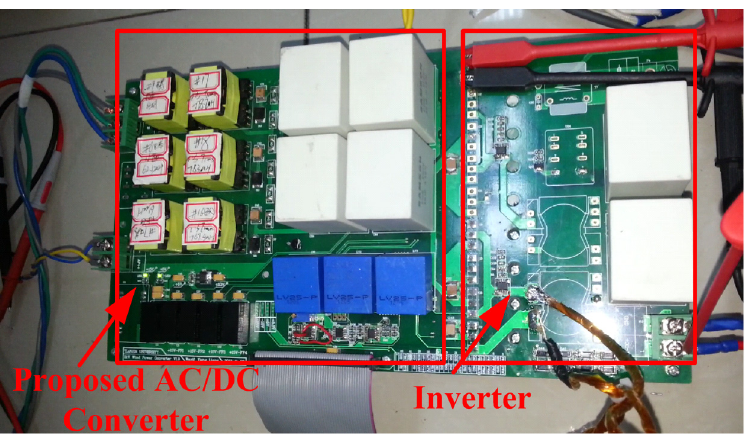
Figure 18. The proposed converter